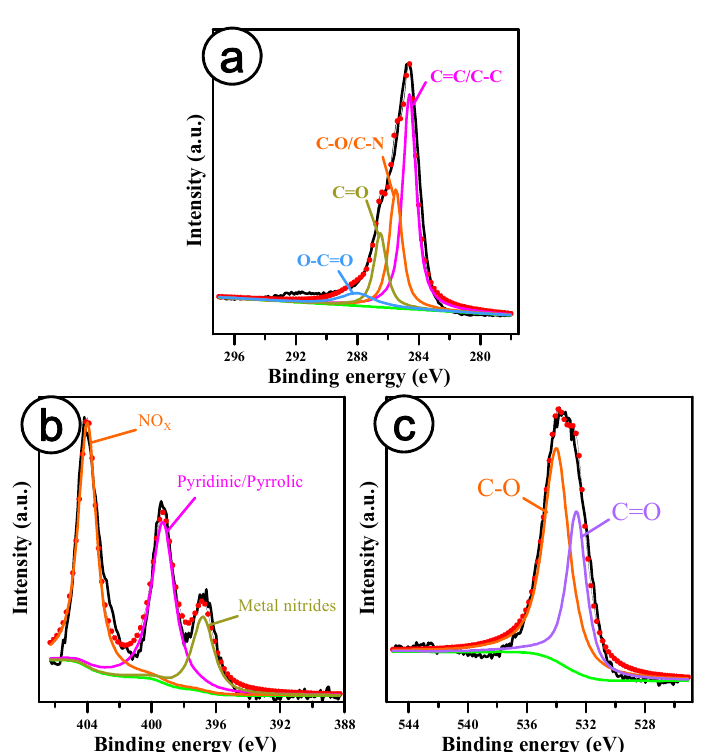
Figure 3. XPS spectra of ( a ) C 1s, ( b ) N 1s, and ( c ) O 1s peaks of N-doped GQD sample.